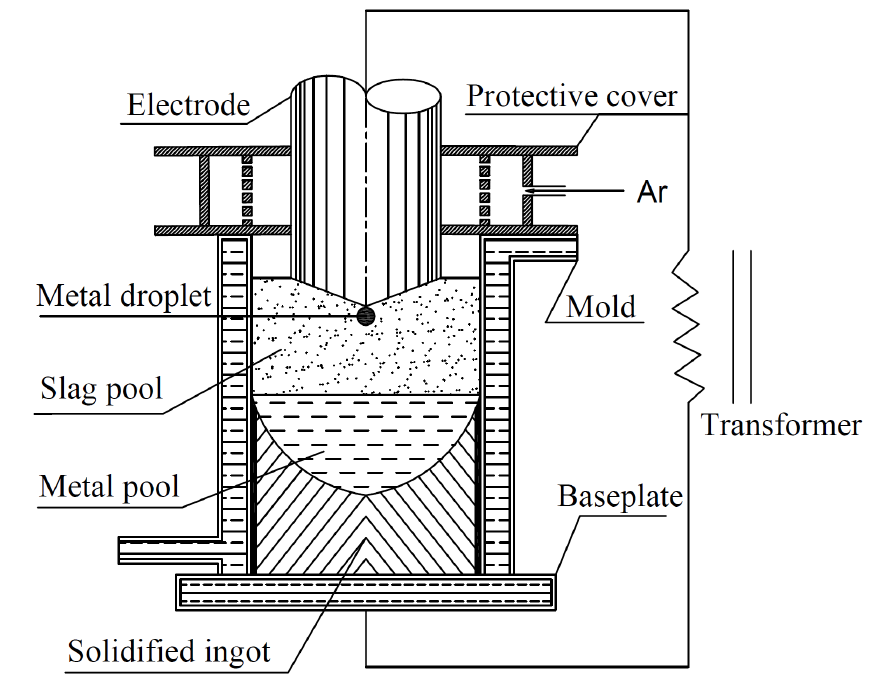
Figure 1. Electroslag remelting furnace with gas protection.